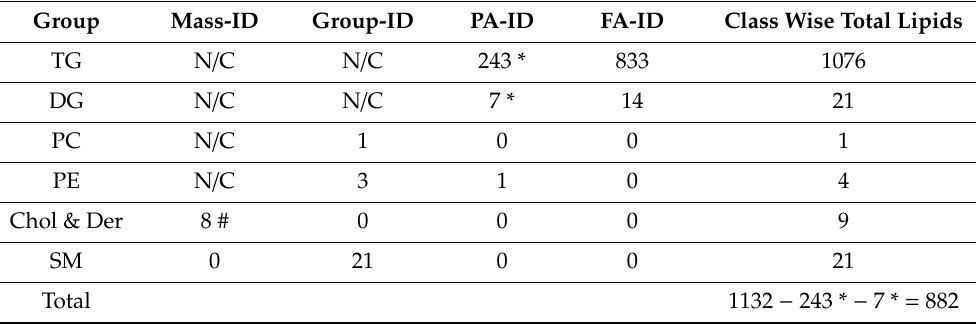
Table 2. Breakdown of the 5 / 10 ppm LIPIDMAPS